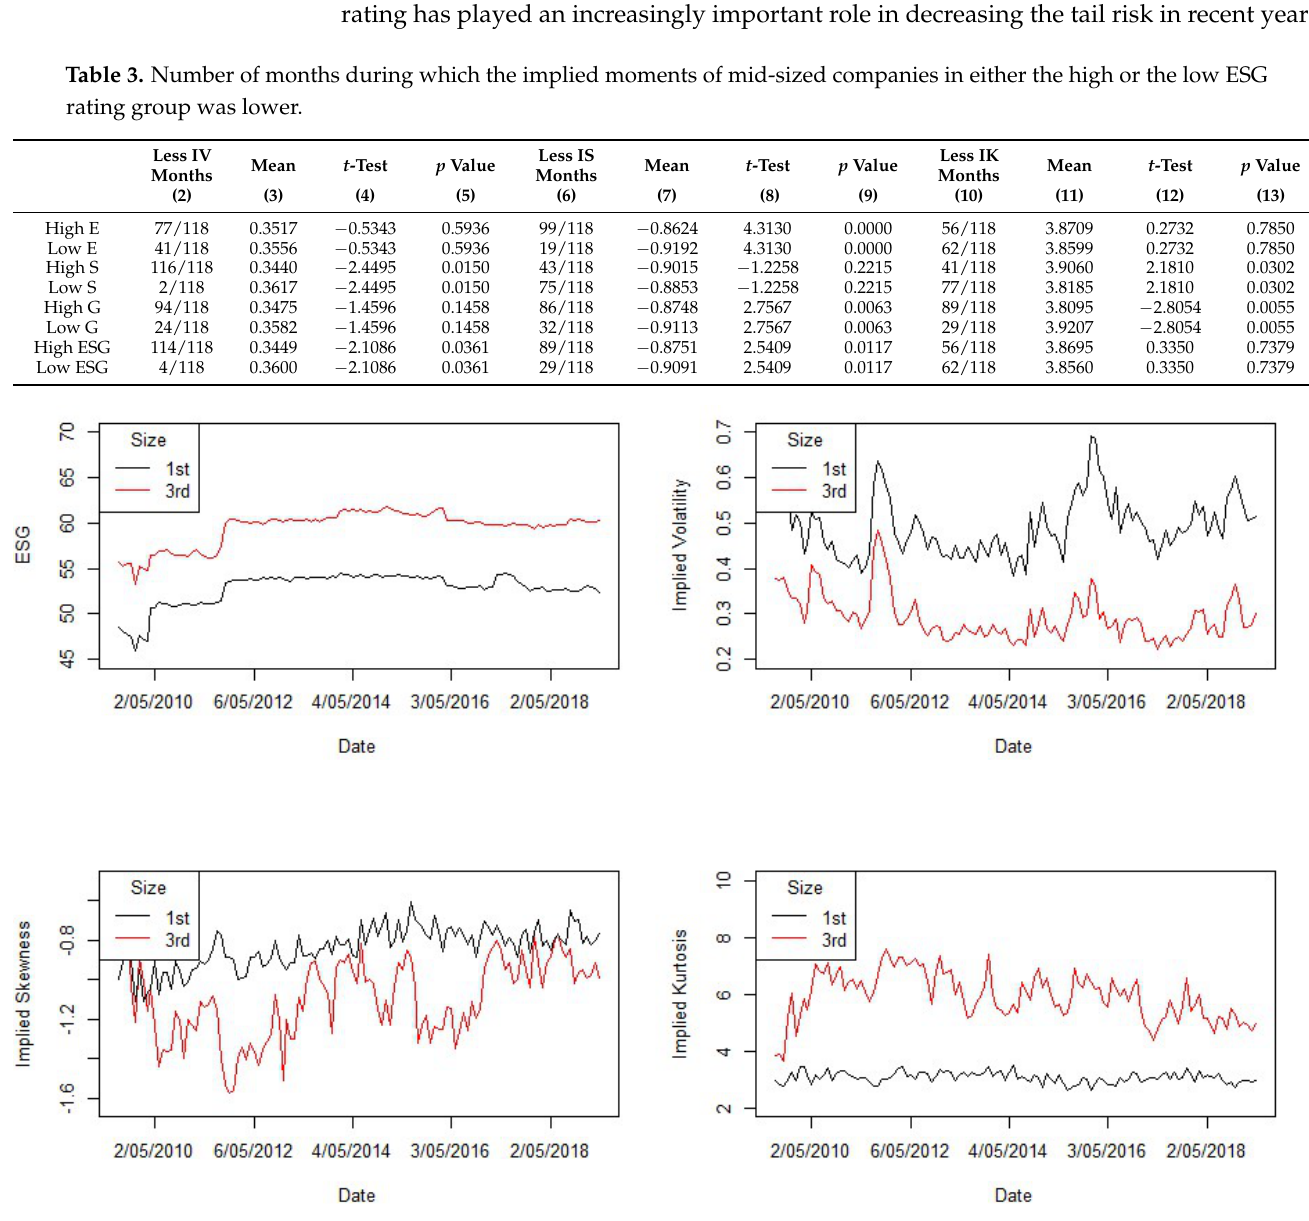
Figure 2. ESG composite rating and implied moments of large and small sized company